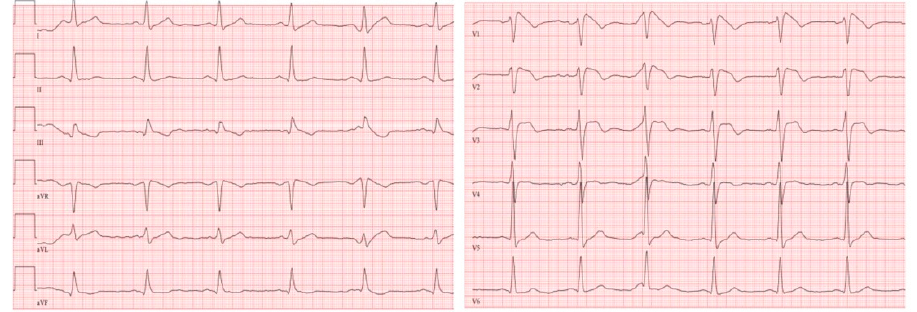
Figure 3. 47 year old male and previously healthy patient with transient “Brugada like” ECG pattern in the right precordial leads related to the diagnosis of COVID-19.